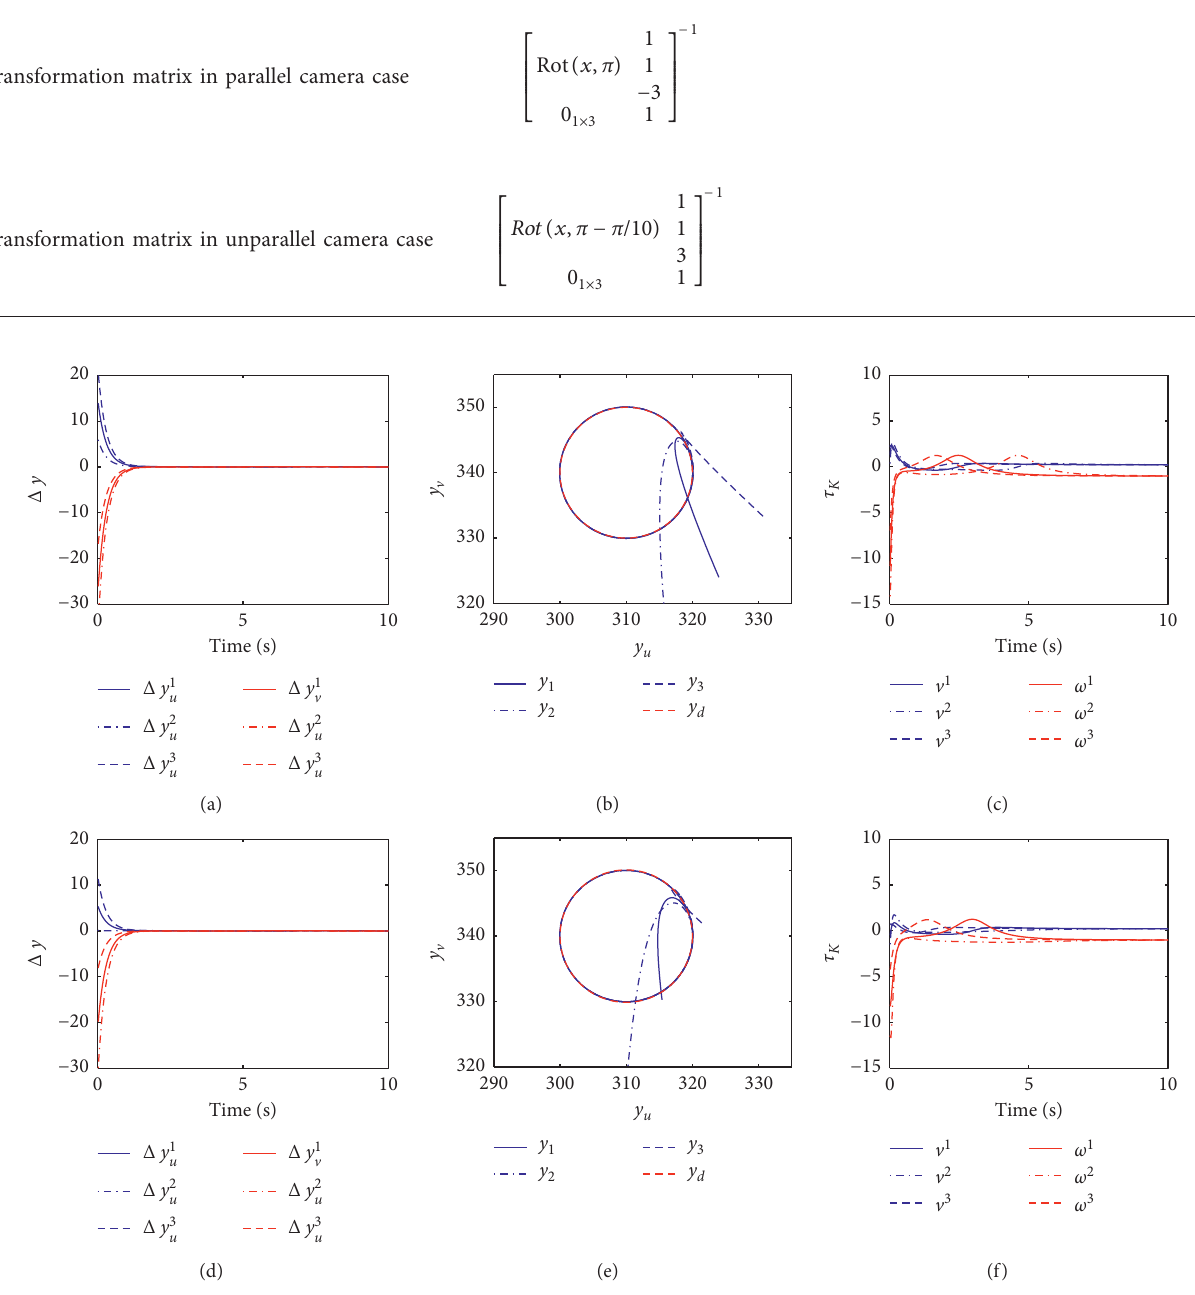
Figure 2: Control responses of AVSKC schemes. (a) Position errors on image plane in PCC. (b) The real and desired trajectory in PCC. (c) Control input in PCC. (d) Image errors in UPCC. (e) The real and desired trajectory in UPCC. (f) Control input in